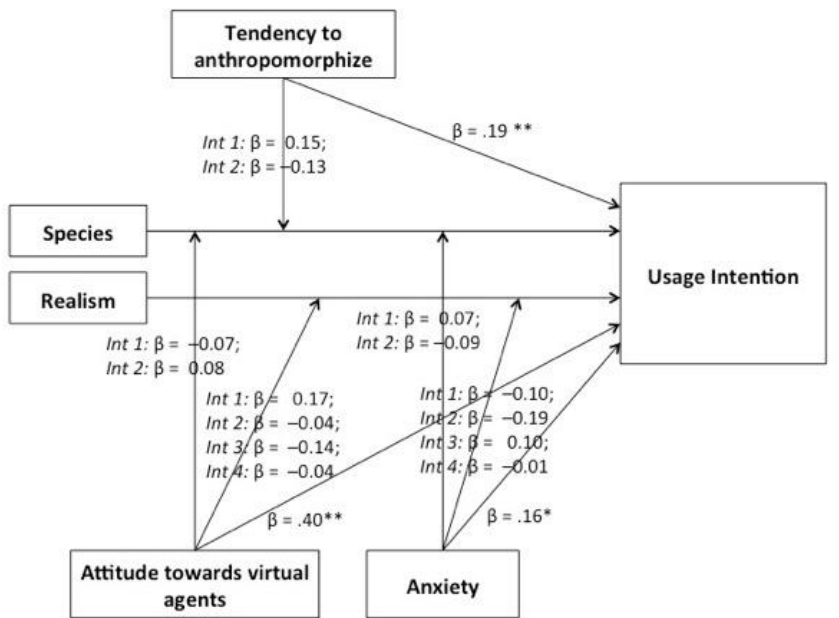
Figure 4. Conceptual model of the moderating variables’ effects on usage intention. Standardized regression coefficients are presented (* indicates a p value < 0.005 and ** <0.001). For the moderation analyses, independent variables were dummy coded (species: Int 1 = human vs. animal, Int 2 = human vs. robot; realism: Int 1 = high detail vs. low detail, Int 2 = high detail vs. cartoon proportions, Int 3 = high detail vs. cartoon shade, Int 4 = high detail vs. cartoon proportions with cartoon shade) and data were standardized before running the analyses.